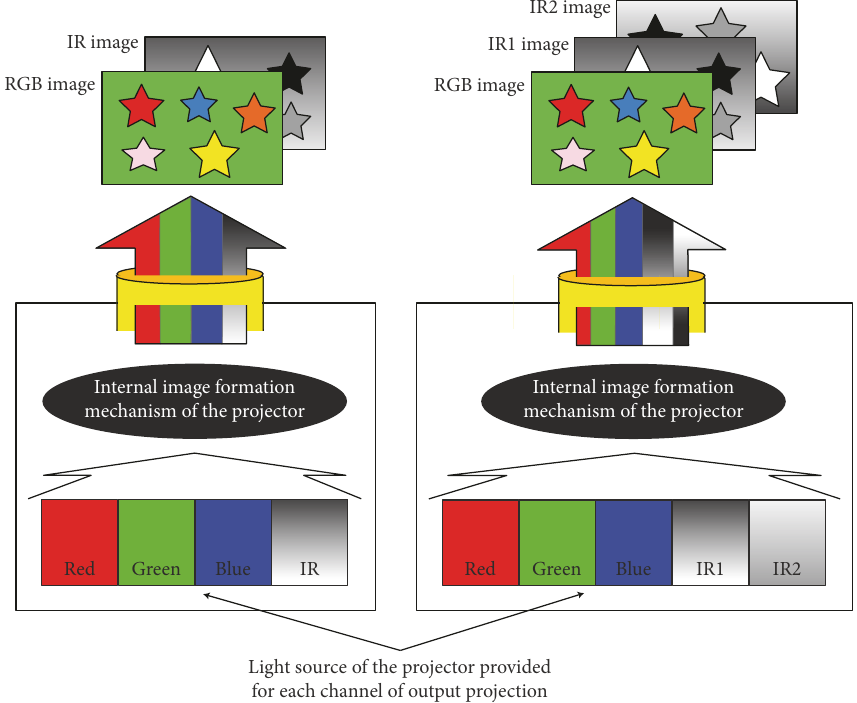
Figure 2: Concept of an IR-RGB dual-input projector with a single projection lens. Left and right images represent four- and five-channel projection mechanisms regarding one and two additional infrared wavelengths, respectively. Note that the actual implementation may be varied, depending on projection technology.